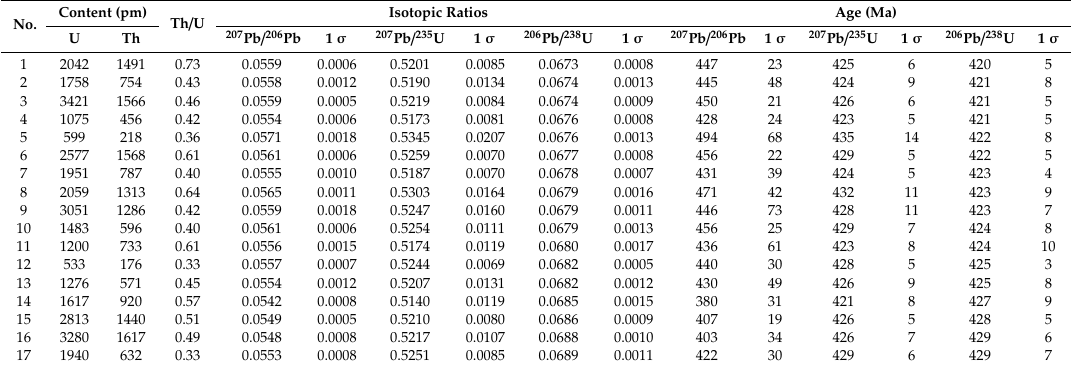
Table 2. LA-ICP-MS U-Pb dating data of gabbro in the Akechukesai IV mafic -ultramafic complex. Content(pm) Th / No.